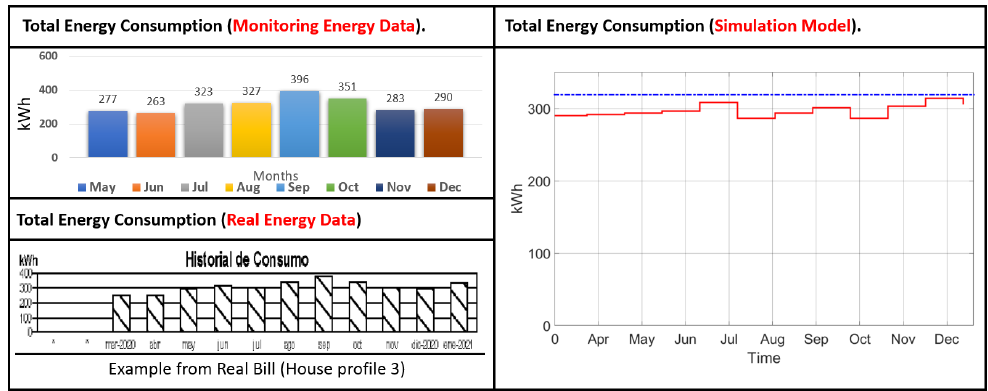
Figure 14. Total energy consumption from smart meter, bill, and simulation